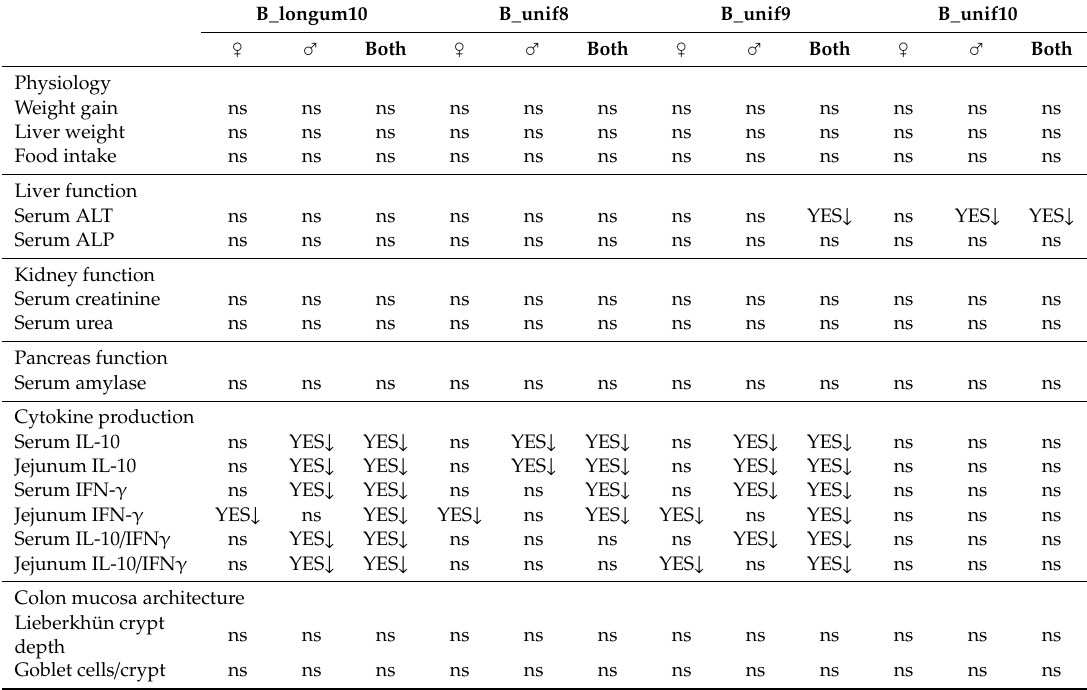
Table 1. Summary of di ff erent assessments to support the safety of B. uniformis CECT